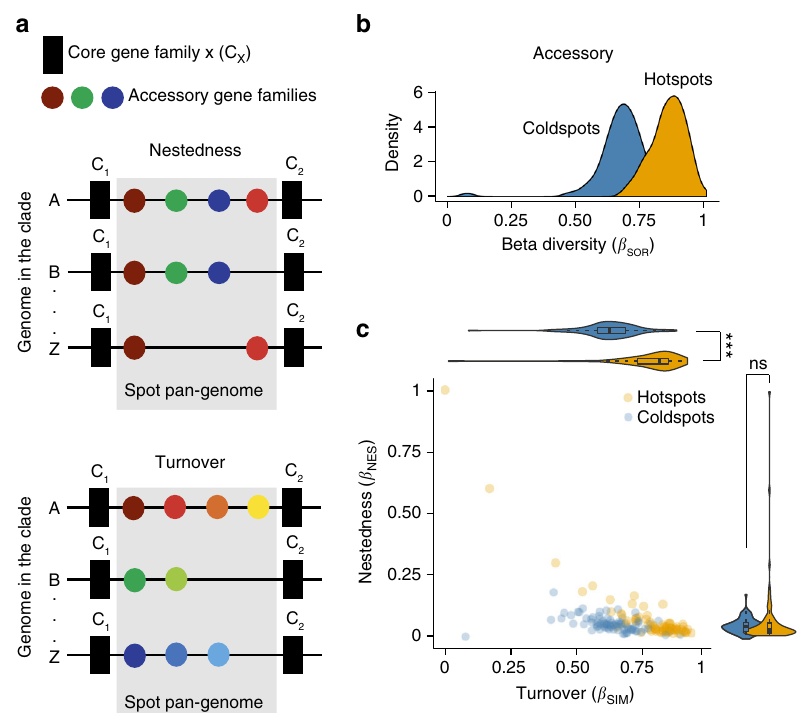
Fig. 7 Genetic diversity of the accessory genes present in hotspots and coldspots. a Examples of gene nestedness and turnover in a spot. Turnover measures the segregation between intervals in terms of gene families, i.e., it accounts for the replacement of some genes by others. Nestedness accounts for differential gene loss and measures how the gene repertoires of some intervals are a subset of the repertoires of the others. It typically re fl ects a non-random process of gene loss. b Distributions of β diversity ( β SOR ) in hotspots and coldspots. c Partition of β SOR in its components of nestedness ( β NES ) and turnover ( β SIM ) for hotspots and coldspots ( β SOR = β NES + β SIM ). *** P < 10 − 3 ; Mann – Whitney – Wilcoxon test; ns: not signi fi